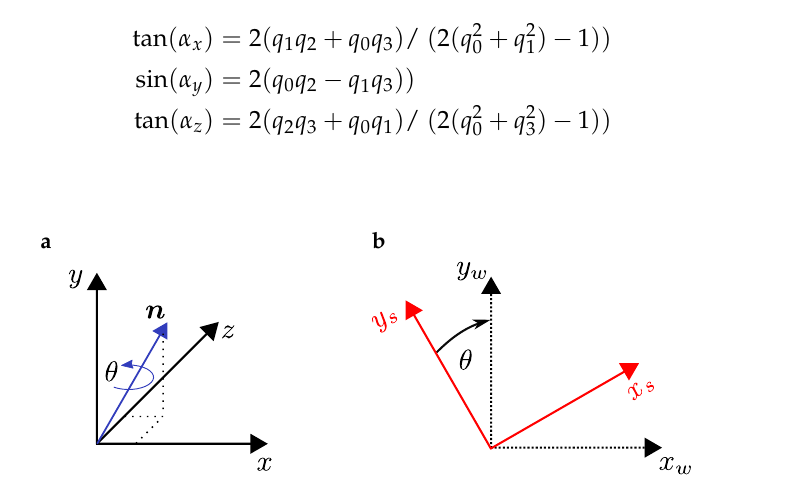
Figure A1. ( a ) 3D-rotation around axis n by angle θ ; ( b ) Alignment of two coordinate